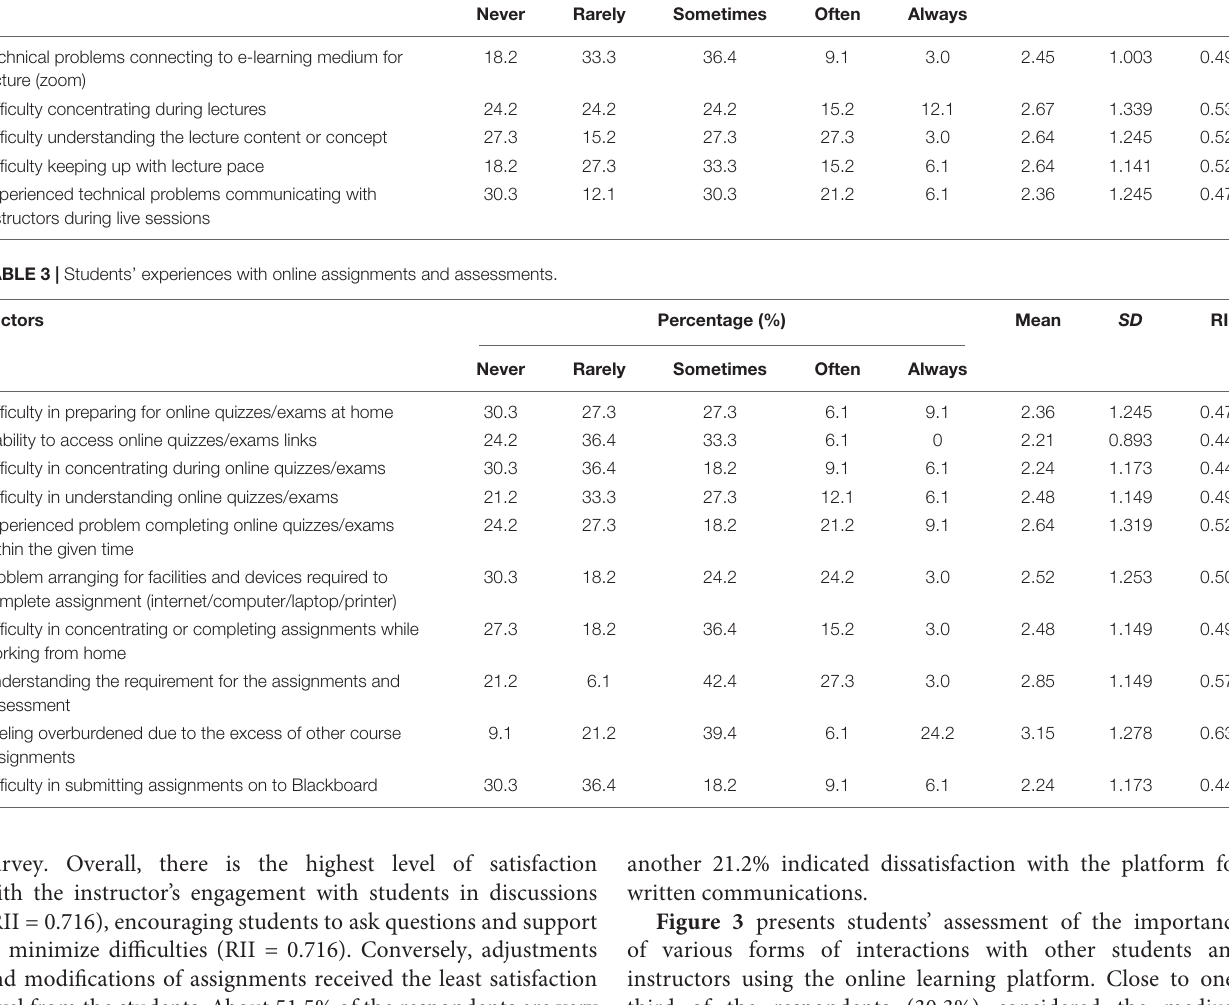
Figure 4 reveals that, overall, participants expressed a greater (27%) preference for WhatsApp messaging, followed by email correspondence (22%) and Blackboard announcements